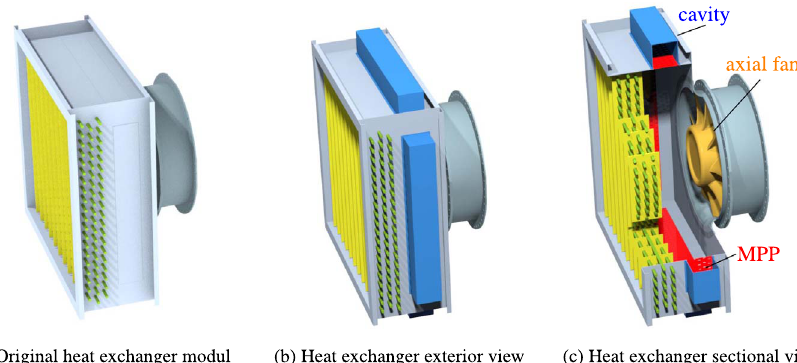
Figure 1. Reference heat exchanger module (heat exchanger + axial fan) with rigid walls (a) and modi fi ed case with built-in MPP (red) and additional cavities (blue) (b and c). Heat exchanger consists of housing (gray), coolant tubes (green) and cooling fi ns (yellow).